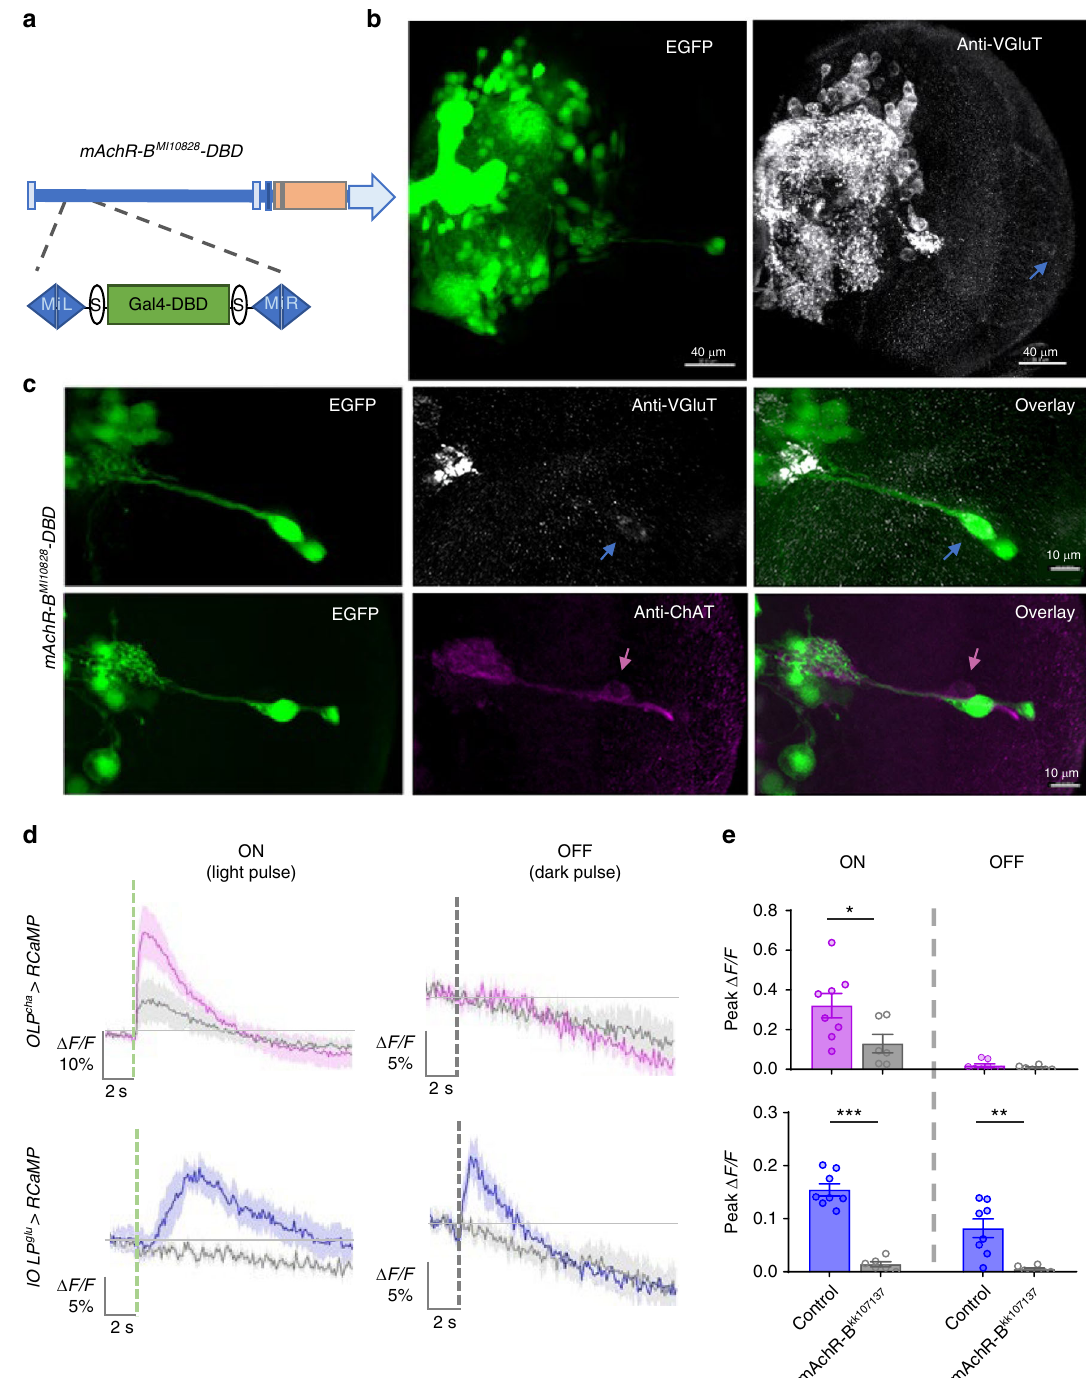
Fig. 4 mAchR-B mediates light-induced inhibition of glu-OLP. a Schematic diagram illustrating the insertion of a Gal4-DBD element into the 5 ′ -UTR region of the mAchR-B gene. Orange bar: coding exons. Light blue bar: introns. b The mAchR-B enhancer line reveals broad expression of the receptor in the third instar larval brain. Representative projected confocal images with EGFP expression driven by the mAchR-B enhancer (green) and anti-VGluT staining (gray) are shown. Blue arrow: glu-lOLP. c mAchR-B expresses in glu-lOLP but not cha-lOLP. The mAchR-B enhancer-driven EGFP signal colocalizes with the VGluT-positive glu-lOLP (blue arrow), but not with the ChAT-positive cha-lOLP (pink arrow). Representative projected confocal images are shown. Scale bars are as indicated. d , e Expression of mAchR-B RNAi dampens cha-lOLP ’ s ON response and eliminates both glu-lOLP ’ s ON and OFF responses. The dashed green and gray lines indicate the 100 ms light or dark pulse, respectively. The genotypes are as indicated. The d average traces of the changes in lOLP > RCaMP signals and e quanti fi cation of peak values of changed intensity ( Δ F / F ) are shown. Shaded areas on traces and error bars on quanti fi cations represent SEM. Control, n = 8; mAchR-B KK107137 , n = 6. cha-lOLP, ON: p = 0.0388, t = 2.320, df = 12; cha-lOLP, OFF: p = 0.3201, t = 1.037, df = 12; glu- lOLP, ON: p < 0.0001, t = 10.09, df = 12; glu-lOLP, OFF: p = 0.0028, t = 3.736, df = 12. Statistical signi fi cance was determined by Student ’ s t test. p ≥ 0.05 was considered not signi fi cant, *** p < 0.001, ** p < 0.01, and * p <